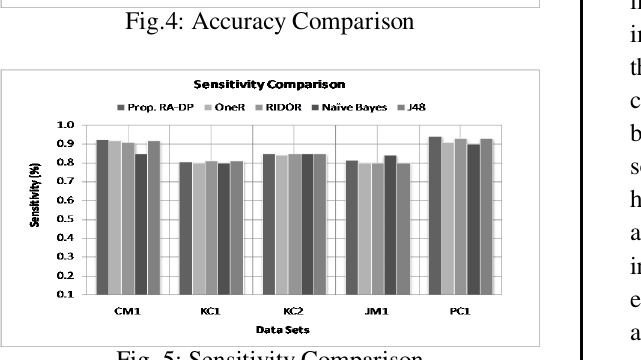
Fig.4: Accuracy Comparison